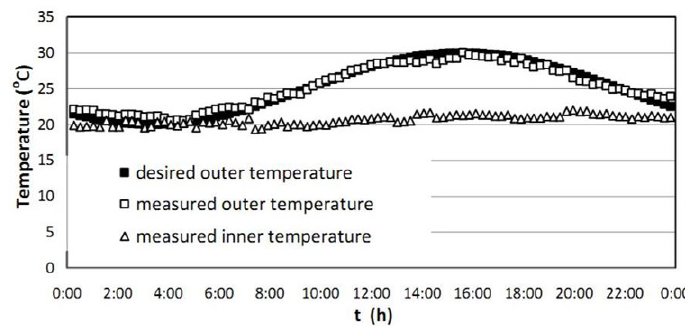
Figure 8. Temperature at the inner and outer side and desired temperature at the outer side. Scenario 1 .